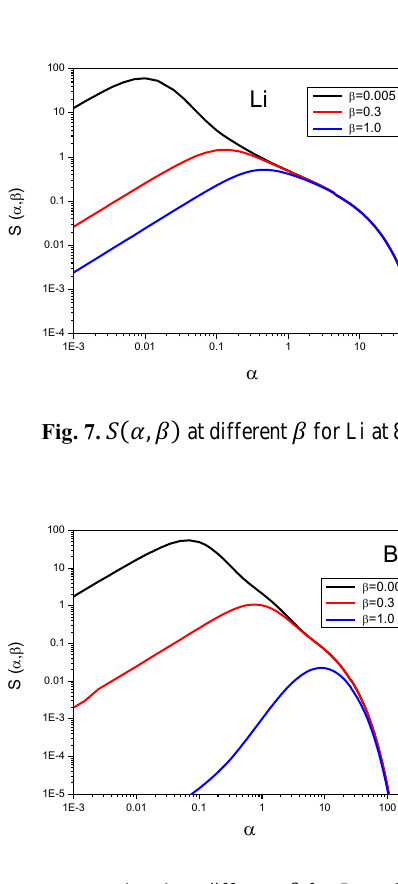
Fig. 8. at different for Be at 800K 𝑆𝑆(𝛼𝛼, 𝛽𝛽) As can be seen, for beryllium and fluorine, higher 𝛽𝛽 temperature liquid molten salt LiF-BeF 2 systems exhibit a lower thermal neutron scattering cross section. On the contrary, for lithium, when the temperature of liquid molten salt is higher, the thermal neutron scattering cross section is higher.